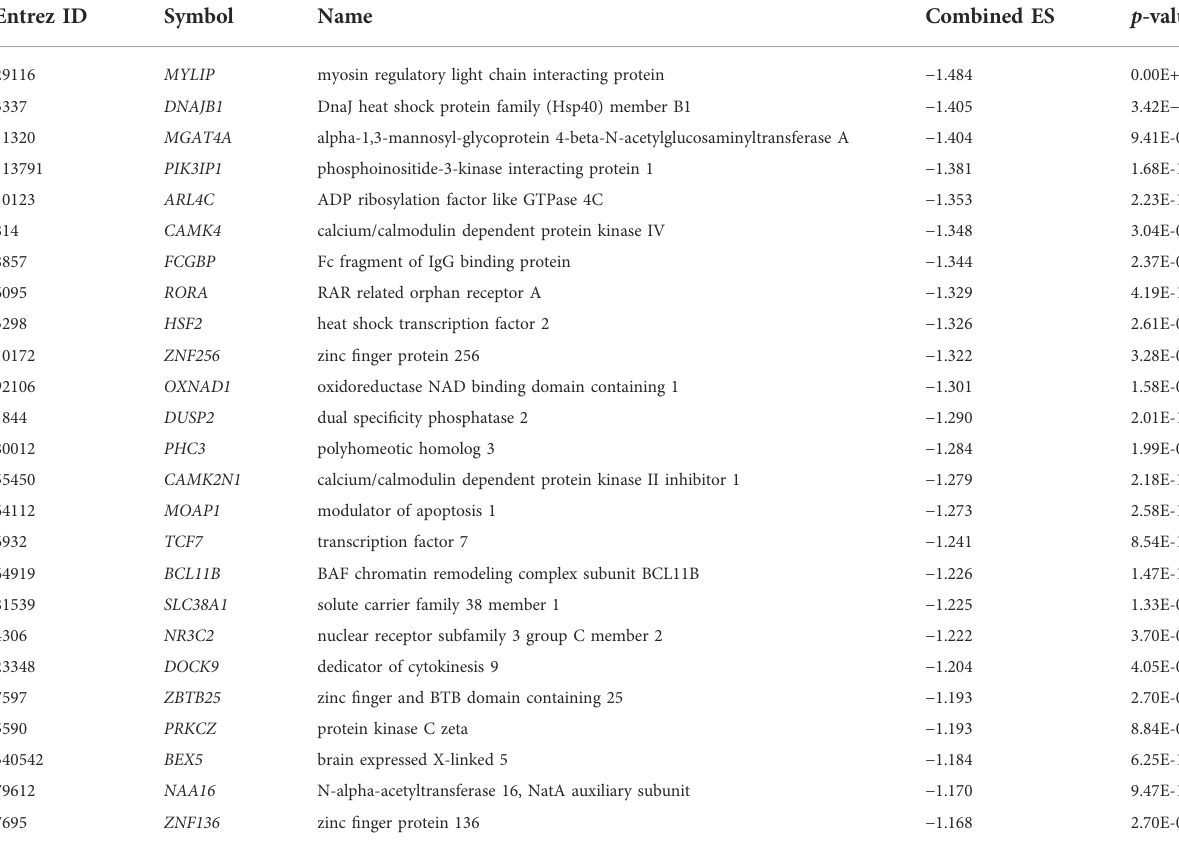
TABLE 3 The top 25 down-regulated genes (the lowest ES) in the blood cells of patients with PAH relative to normal samples. Entrez